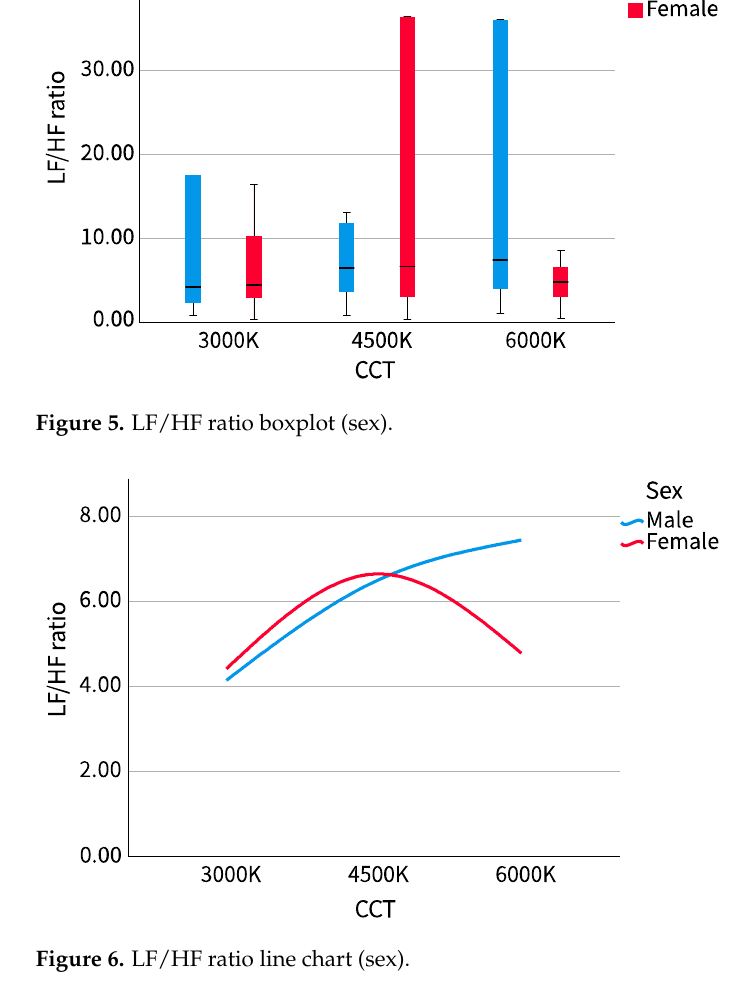
Figure 7. LF/HF ratio boxplot (major).